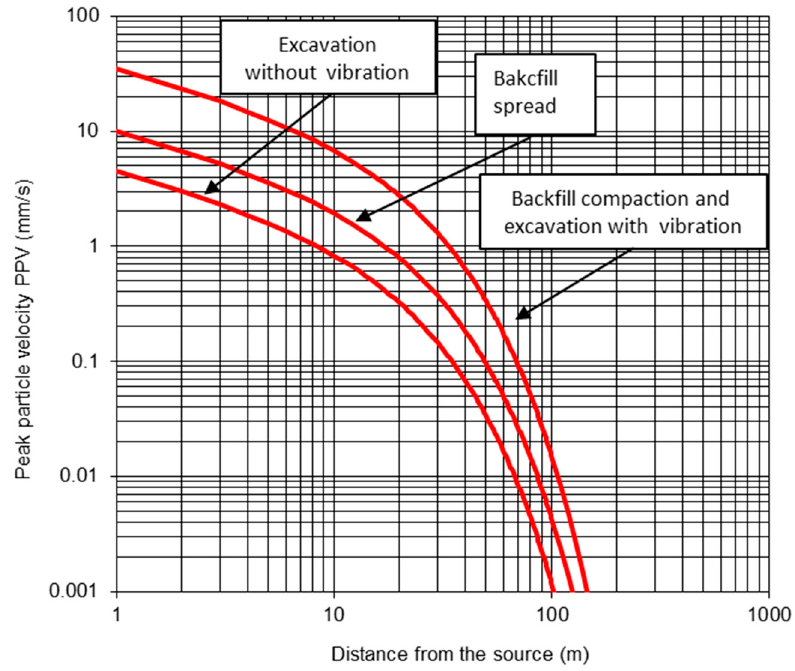
Figure 8. Vibration behavior of the equipment, based on the distance.